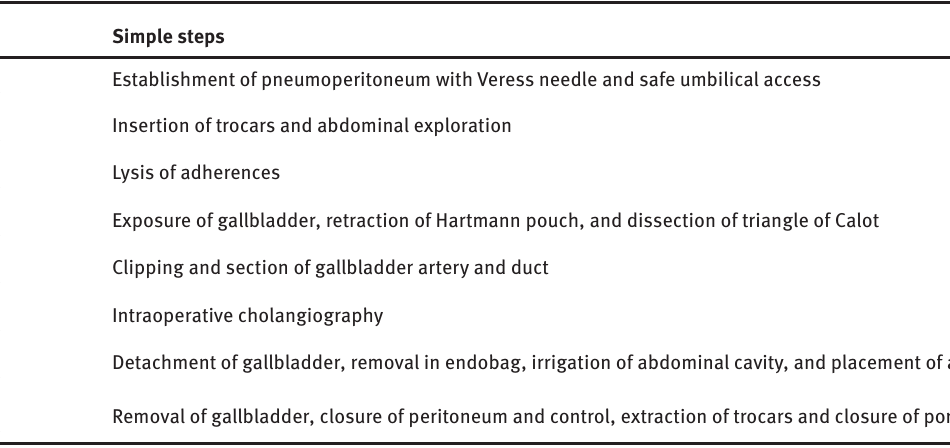
Table 1: Key steps in videolaparoscopic